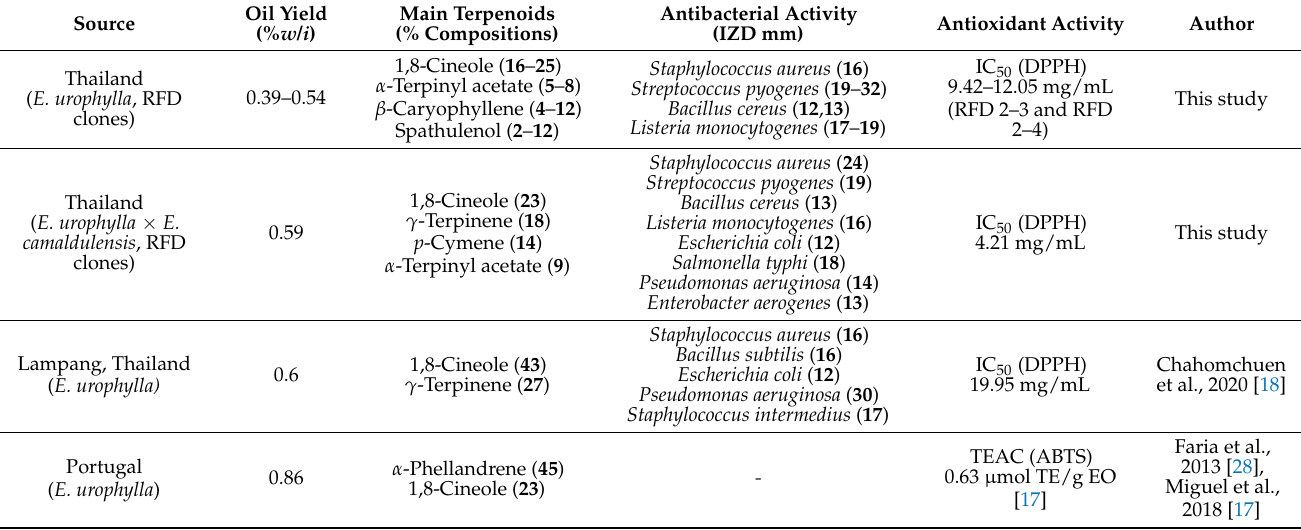
Table 2. Comparison of essential oil yields, main terpenoids, and antibacterial and antioxidant activities of E. urophylla leaf oils with some those of previous